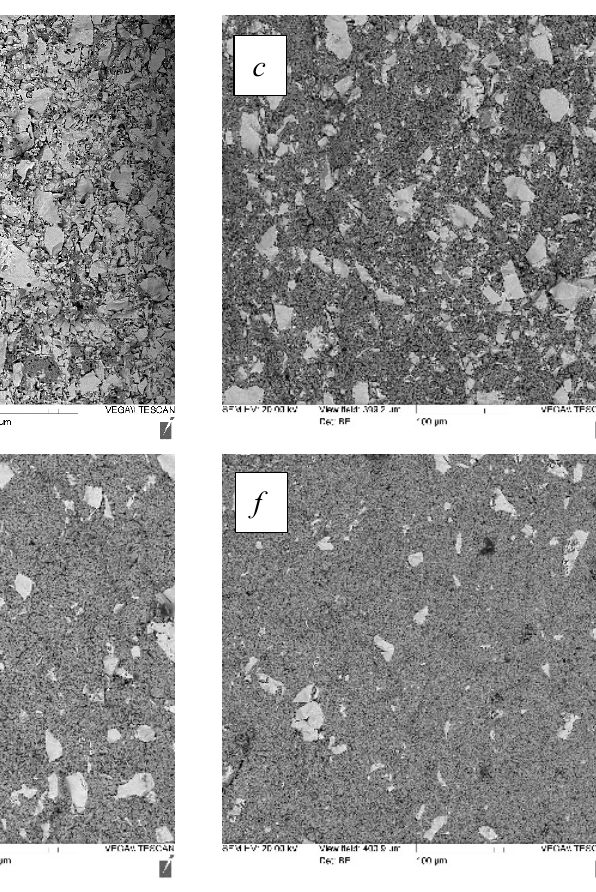
Figure 3. SEM images of (100 − x) wt.% BCZT + x wt.% NCCMF composite ceramics, ( a ) ferrite grain morphology, ( b ) microstructure of the composite x = 20 with a predominant 3-0 connectivity type, ( c – f ) illustration of the predominant 0-3 connectivity type in composites with x = 60–90.